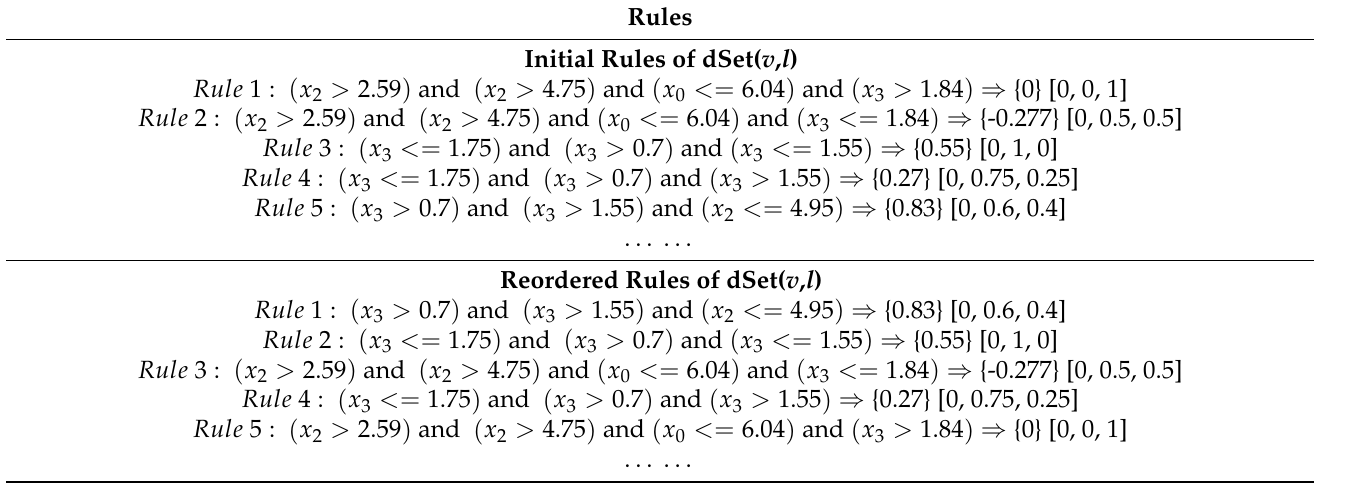
Table 1. One example of decision set reordering. The first five rules are extracted from the v -th RF and are rearranged based on the final contribution. Each rule has a pair of contributions and probabilities of a